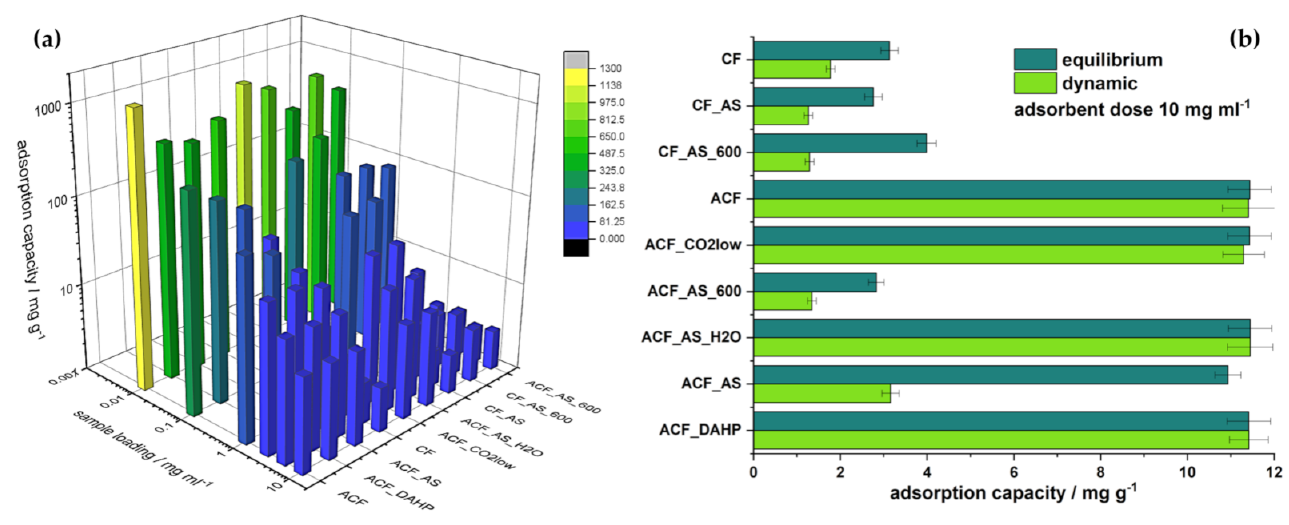
Figure 3. ( a ) Adsorption capacities of studied samples for different adsorbent doses from 10 to 0.01 mg mL − 1 ; ( b ) comparison of adsorption capacities under batch and dynamic conditions (filtra- tion) for an adsorbent dose of 10 mg mL − 1